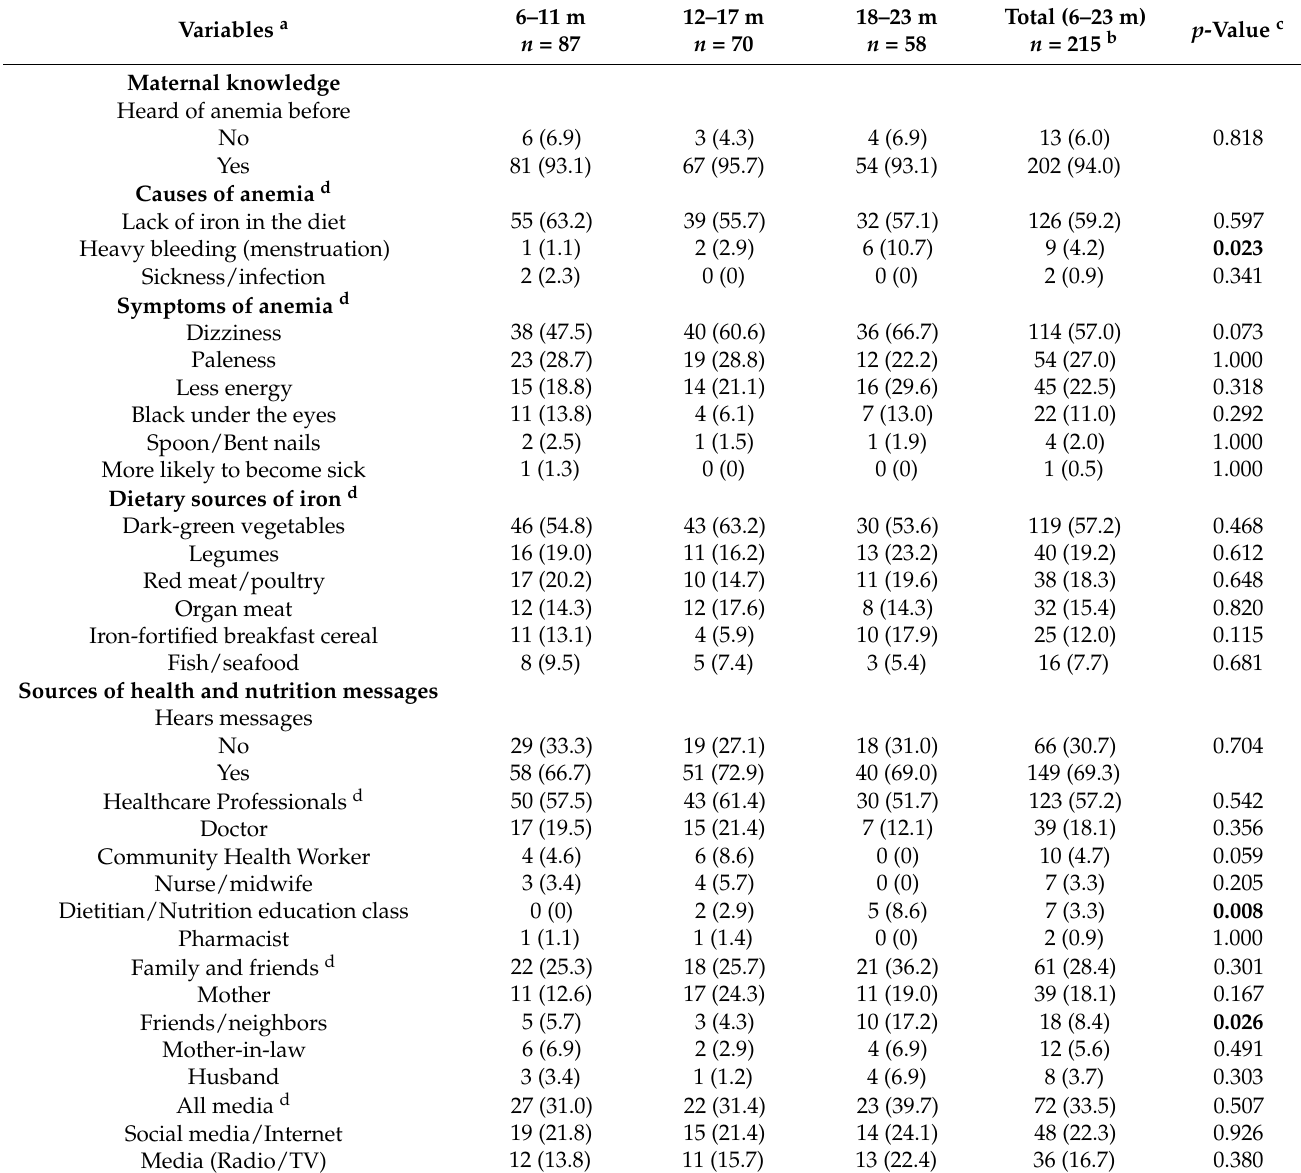
Table 4. Knowledge of mothers of Syrian refugee children aged 6 to 23 months on anemia and sources of health and nutrition messages (Quantitative assessment, Source: